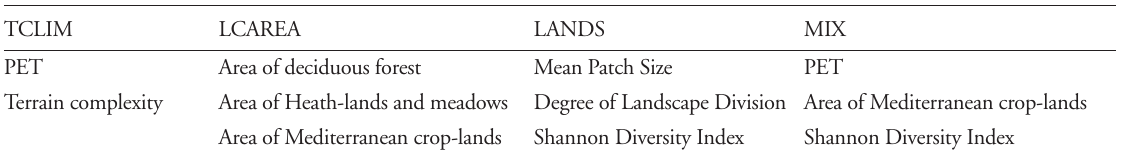
Table 2. The four groups of predictor variables: climate and topography (TCLIM), area of main land-covers (LCAREA), landscape structure variables (LANDS) and a mixture of variables belonging to the first three